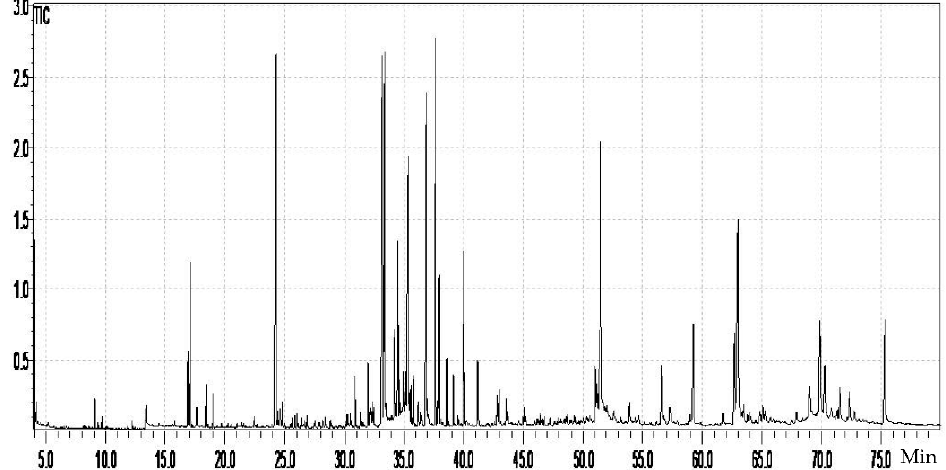
Figure 2. Total ion chromatogram (TIC) of Warionia saharae extract. Table 2. Identified compounds on the hydromethanolic extract of W. saharae aerial parts by GC–MS (µg